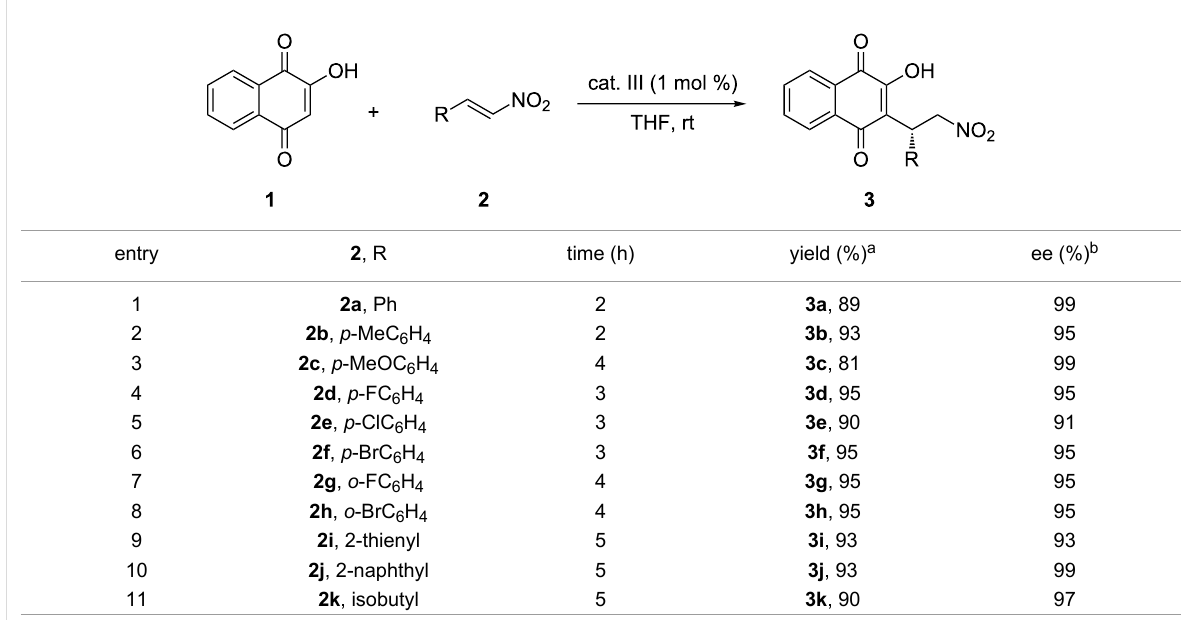
Table 2: Catalytic asymmetric Michael addition of 2-hydroxy-1,4-naphthoquinone 1 to nitroalkenes 2